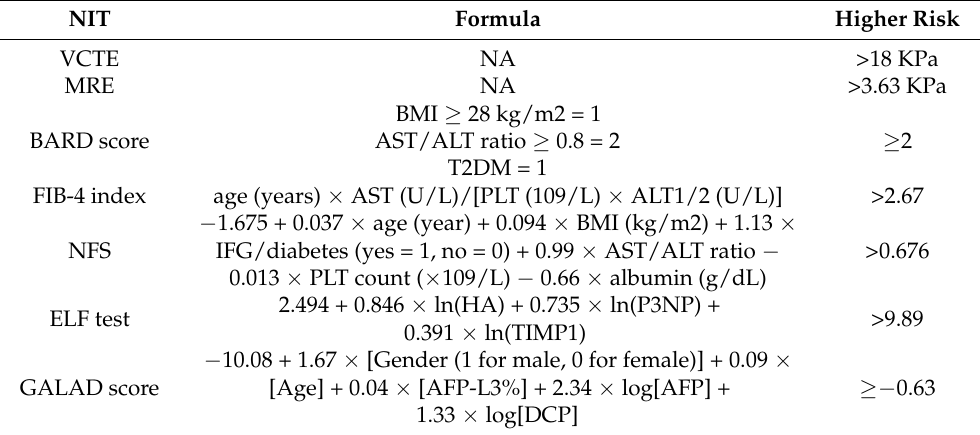
Table 4. Non-invasive tests (NITs) for stratifying NAFLD patients according to the risk of developing HCC. NIT Formula Higher Risk VCTE NA >18